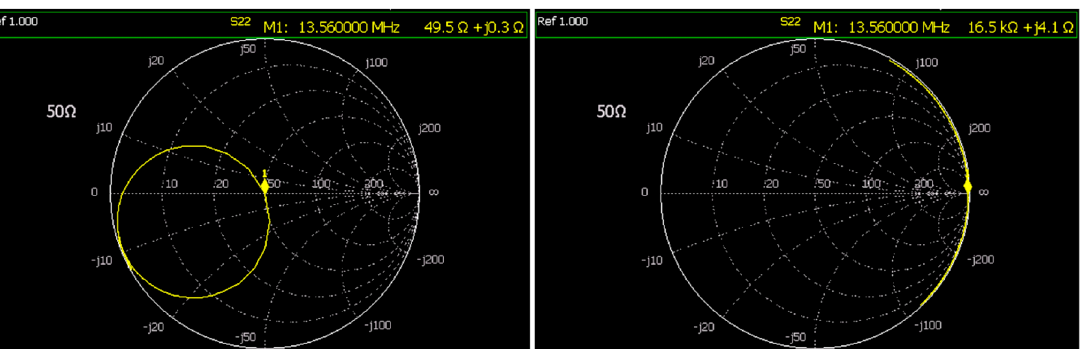
Figure 6. The implemented system for the validation of the 64-channel near-field communication signal acquisition and wireless power transfer, consisting of ( a ) the stationary unit connected to computer, ( b ) the wearable unit connected to a LiPo battery, ( c ) the implantable unit and ( d ) the transmitter coil. The inset shows the side view of the holder used to adjust various distances and angles between the primary and secondary coils.